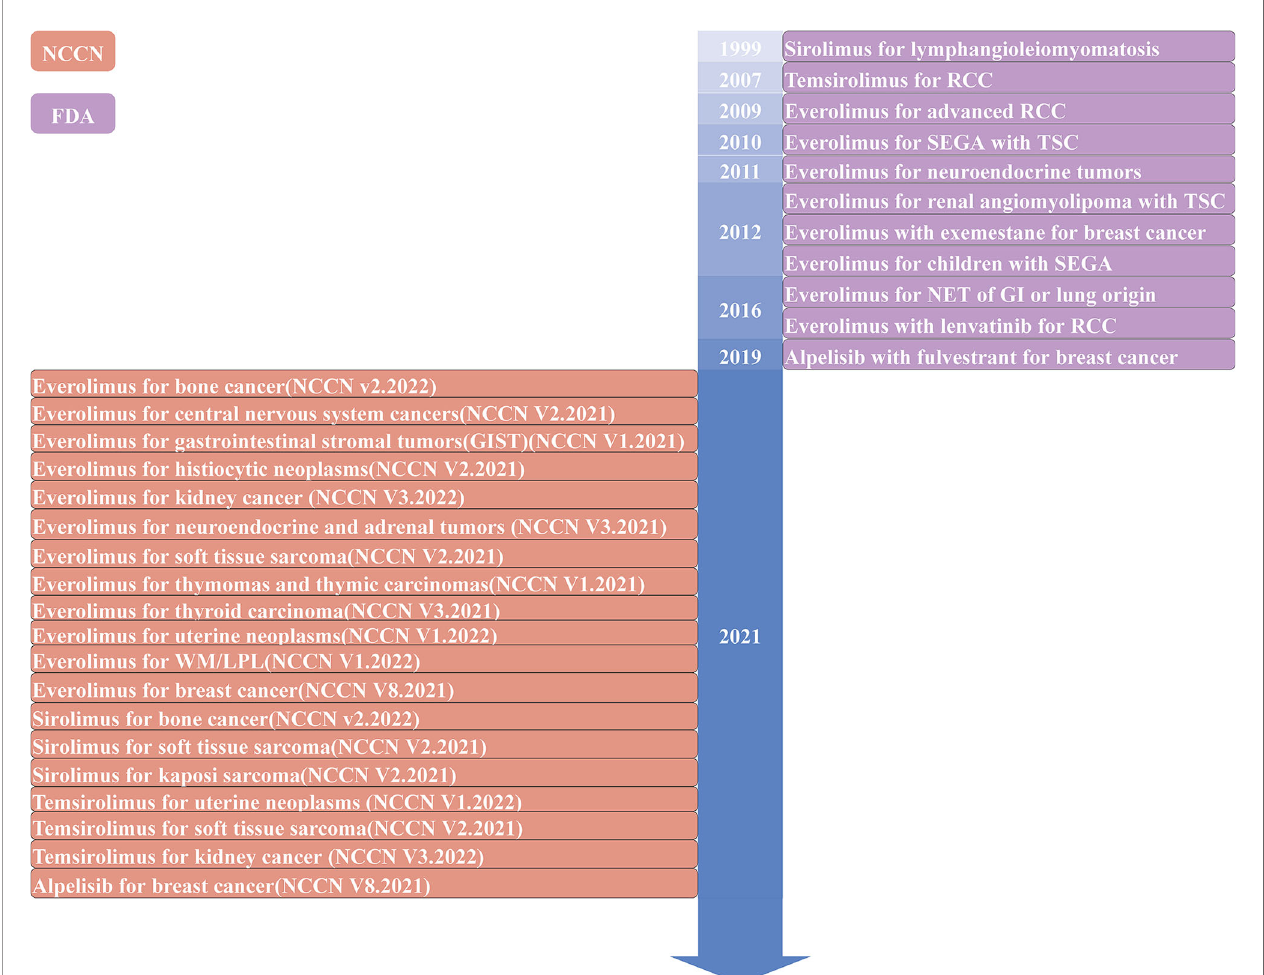
FIGURE 1 | Timeline of The Food and Drug Administration (FDA)-approved or the National Comprehensive Cancer Network (NCCN) recommended inhibitors targeting the PI3K/AKT/mTOR pathway in solid tumors. WM, Waldenstrom macroglobulinemia; LPL, lymphoplasmacytic lymphoma; RCC, renal cell carcinoma; SEGA, subependymal giant cell astrocytoma; TSC, tuberous sclerosis complex; NET, neuroendocrine tumor; GI,